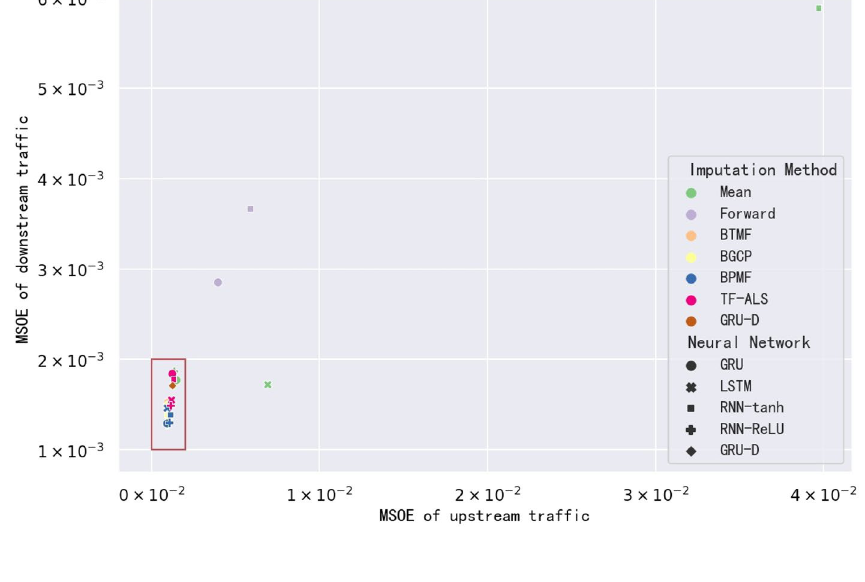
Fig. 11 Partial view of model comparison experiment